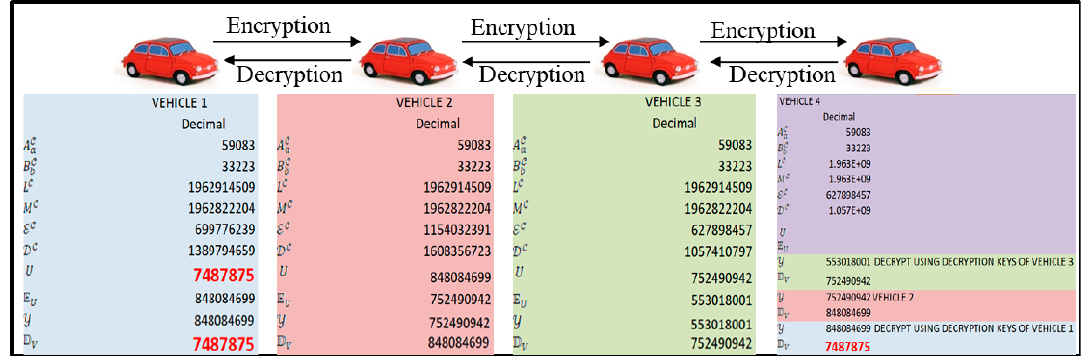
Figure 2. Secure enhanced non-cooperative cognitive division multiple access (S-ENCCMA) with Commutative Rivest–Shamir–Adleman (CRSA).